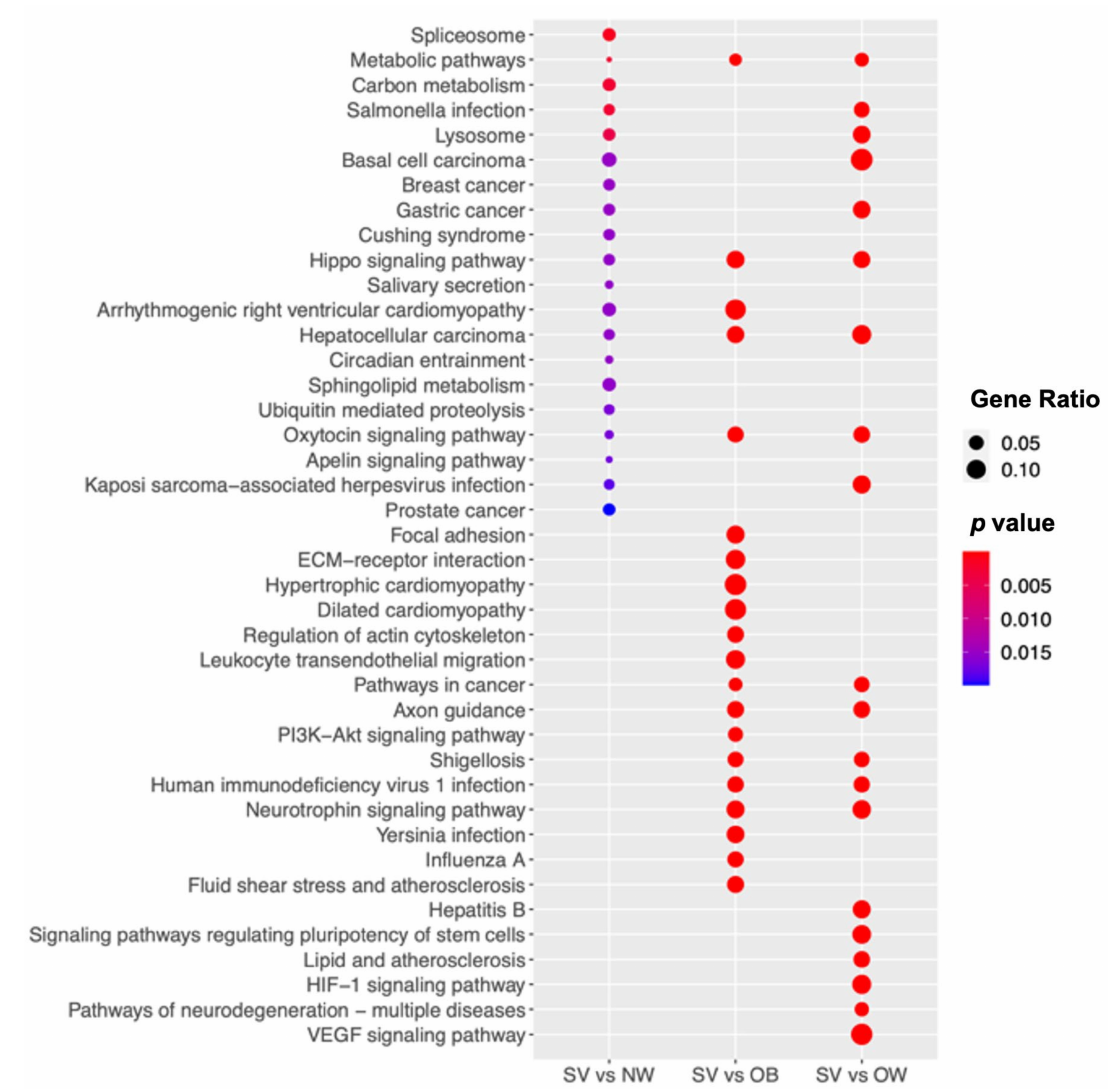
Figure 3. SV group shows significant biologic deregulation. The dot plot shows the KEGG pathway enrichment analyses of the DEGs in SV. The y -axis indicates the pathway name and the x -axis shows the three comparisons: SV vs. NW, SV vs. OB, and SV vs. OW. The dot size represents the gene ratio and the color bar indicates the adjusted p -value (blue represents higher values and red represents lower